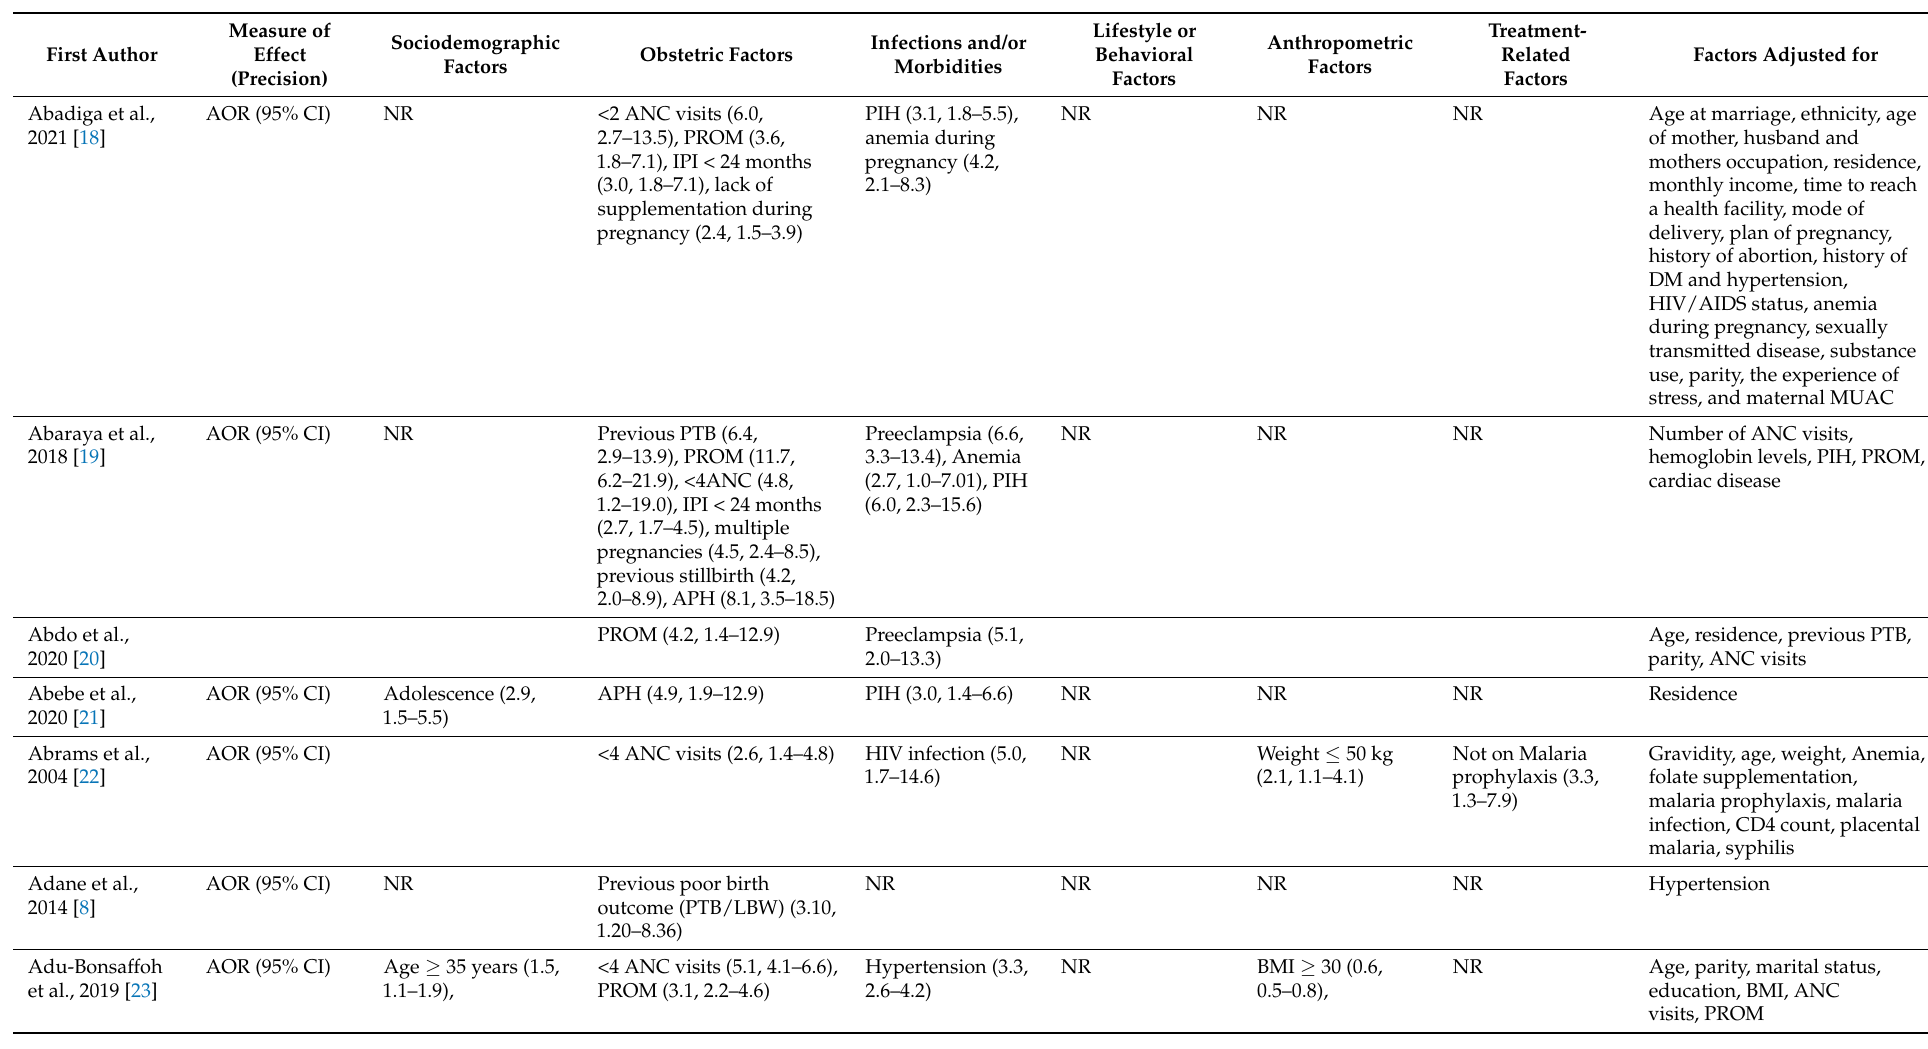
Table 1. Risk factors of PTB in